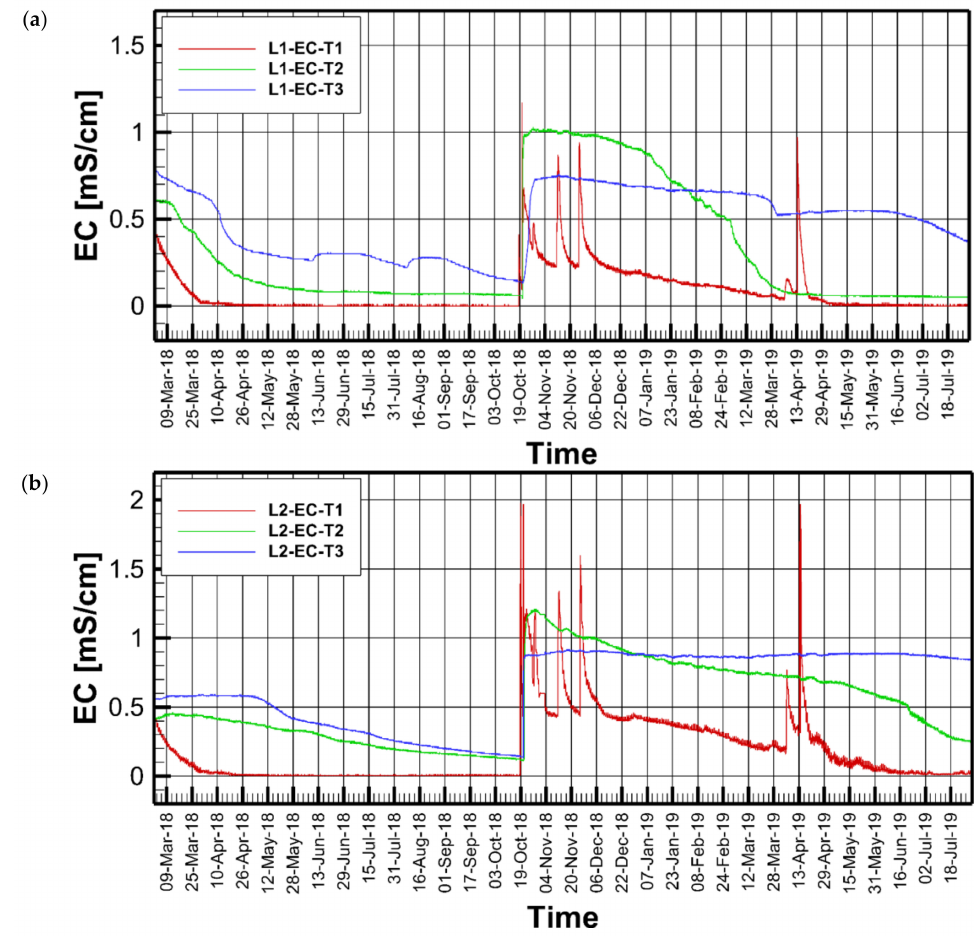
Figure 8. Electrical conductivity of soil at T1 (5 cm), T2 (35 cm), and T3 (55 cm) for lysimeter 1 ( a ) and lysimeter 2 ( b